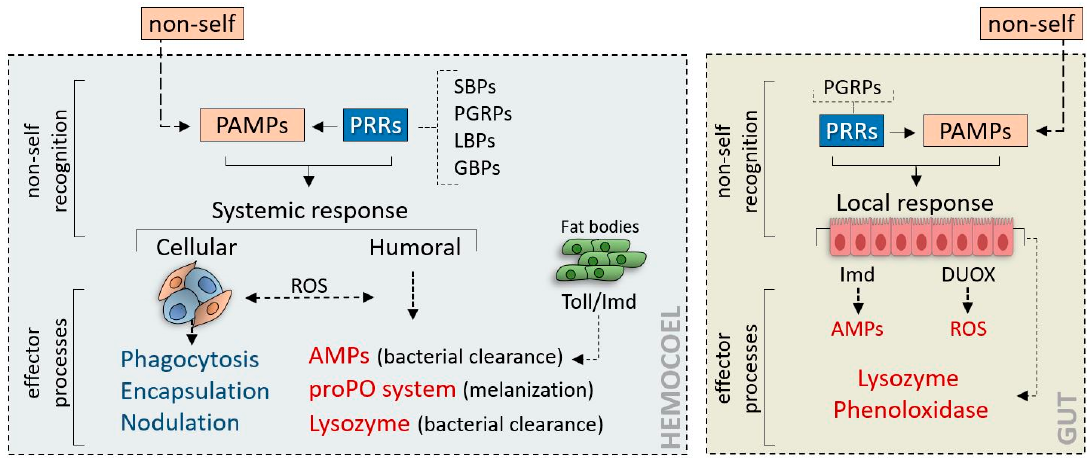
Figure 1. The insect immune system. Insect innate immunity is based on the recognition of non-self by cellular and soluble host receptors; the recognition of foreign molecules (PAMPs) by host receptors (PRRs) initiates a synergistic network of cellular and humoral effector responses aimed at neutralizing the non-self. As in vertebrates, the innate immune response in insects can be triggered systemically (hemocoel, left)andlocally, asinthegut(right). Unlikesystemicinnateimmunity, wheretheTollandImd pathways are essential, the immune response in the gut mucous membrane epithelium depends on the Imd pathway and on the DUOX pathway. SBPs: sugar-binding proteins; PGRPs: peptidoglycan receptor proteins; LBPs: lipopolysaccharide-binding proteins; GBPs: glucan-binding proteins; proPO: prophenoloxidase-phenoloxidase; AMPs: antimicrobial peptides; ROS: reactive oxygen species; DUOX: dual